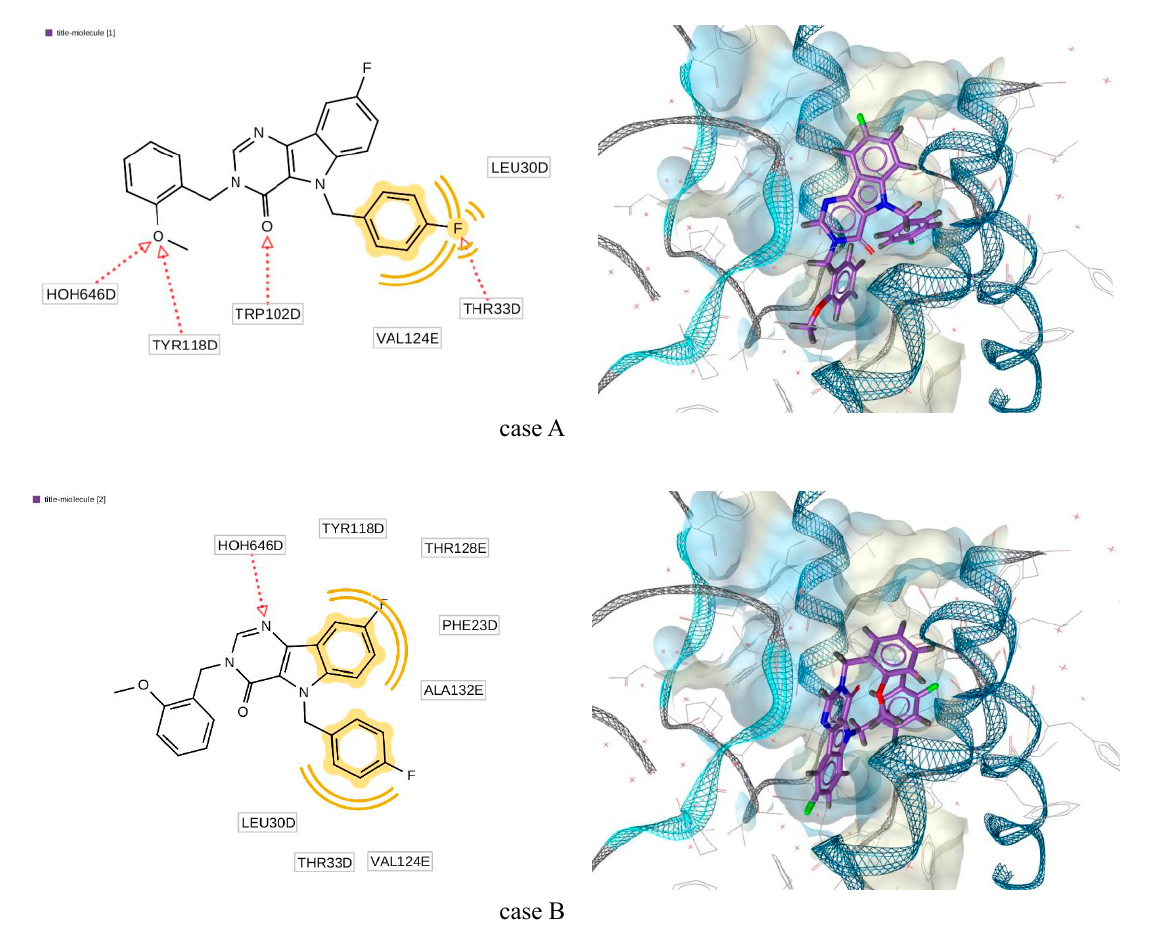
Figure 9. Generated docking pose for complex “title molecule ( 3 )—5E0I”.